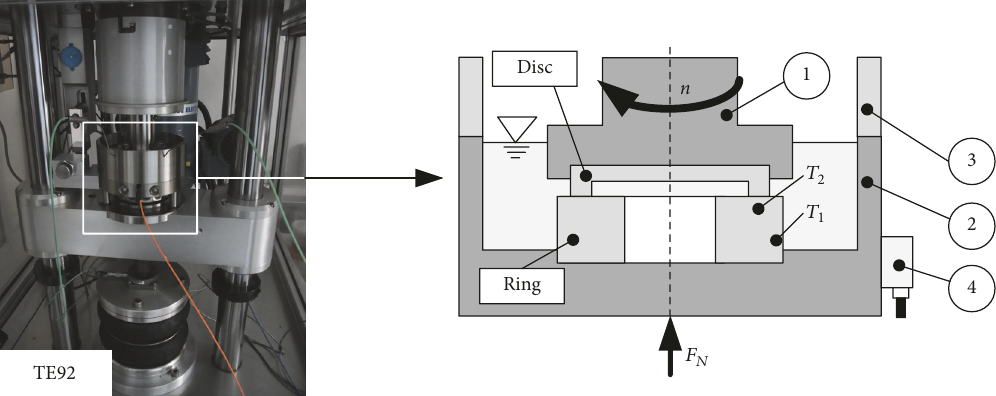
Figure 2: Ring-on-Disc (RoD) test setting and a schematic representation of the test cell. (1) Driving shaft, (2) oil bath, (3) splash guard, and (4) AE sensor.